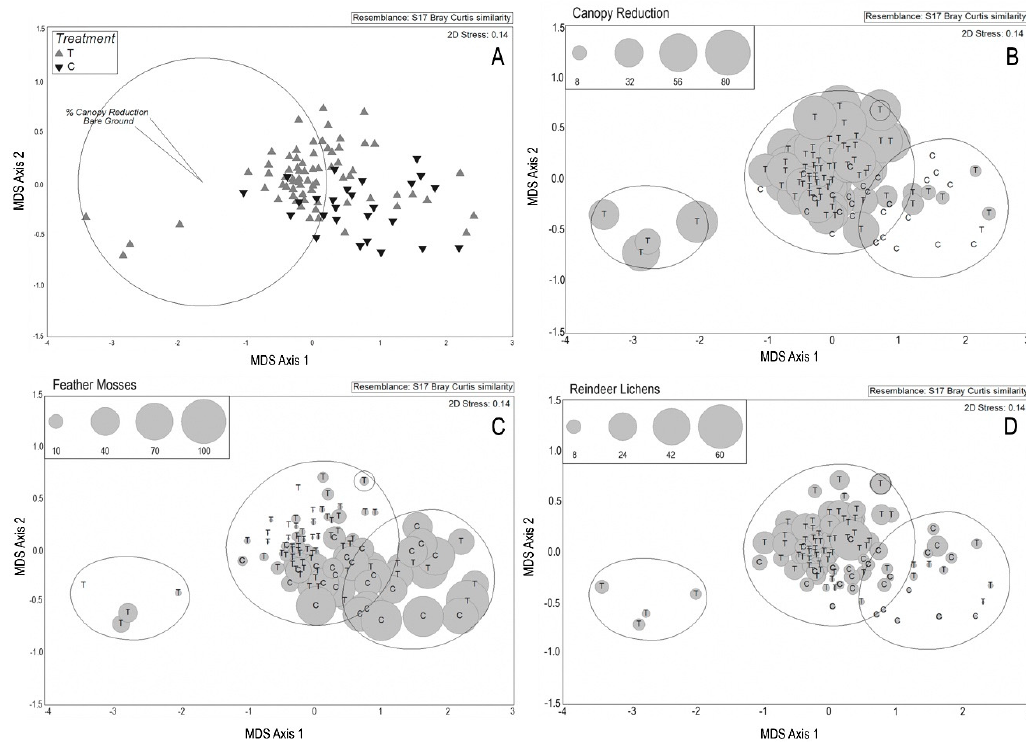
Figure 1. ( A ) Results of non-metric multi-dimensional scaling ordination differentiating treatments and controls with vectors for increasing bare ground and canopy opening in pine-moss-lichen forests in western Alberta, Canada. Each triangle represents one of 97 plots. ( B – D ) Plot abundances overlain on NMDS ordination of 97 plots. Centered letters indicate treatment (T) or control (C). ( B ) Percent canopy cover reduction. ( C ) Feather mosses ( Pleurozium schreberi , Hylocomium splendens , and Ptilium crista-castrensis ). ( D ) Reindeer lichens Cladonia arbuscula/mitis , C. rangiferina/stygia , and C. stellaris ). Sizes of the bubbles were derived from either 2016 densiometer readings (B) or perimeter line transect sums (C-D -see methods).